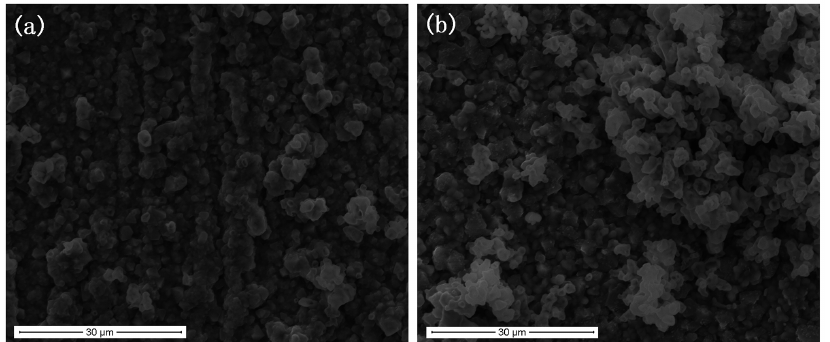
Figure 7: Surface morphology of scale surfaces developed on stainless steel 441 at 1,000°C in air with 11.5 vol.% H 2 O in (a) 2 h, (b) 5